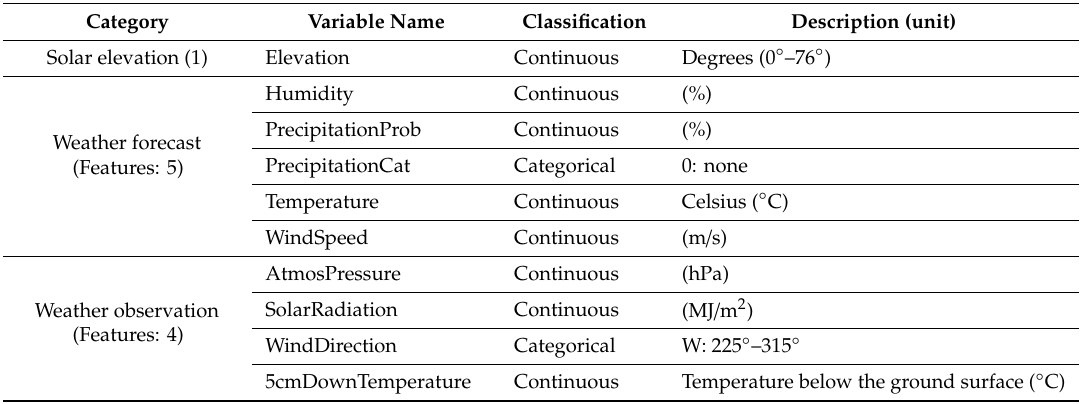
The best values are in underlined boldface. Table 8. Gradient boosting weather variables.